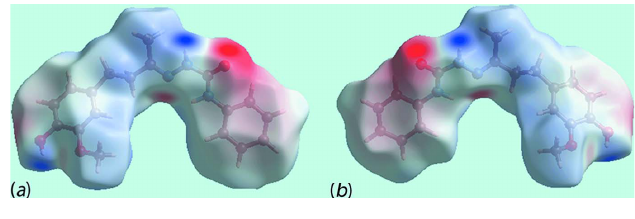
Figure 5 Views of the Hirshfeld surface for (I) mapped over the electrostatic potential in the range (cid:4) 0.103 to + 0.141 au for the ( a ) O1-containing molecule and ( b ) the O4-molecule. The red and blue regions represent negative and positive electrostatic potentials, respectively.